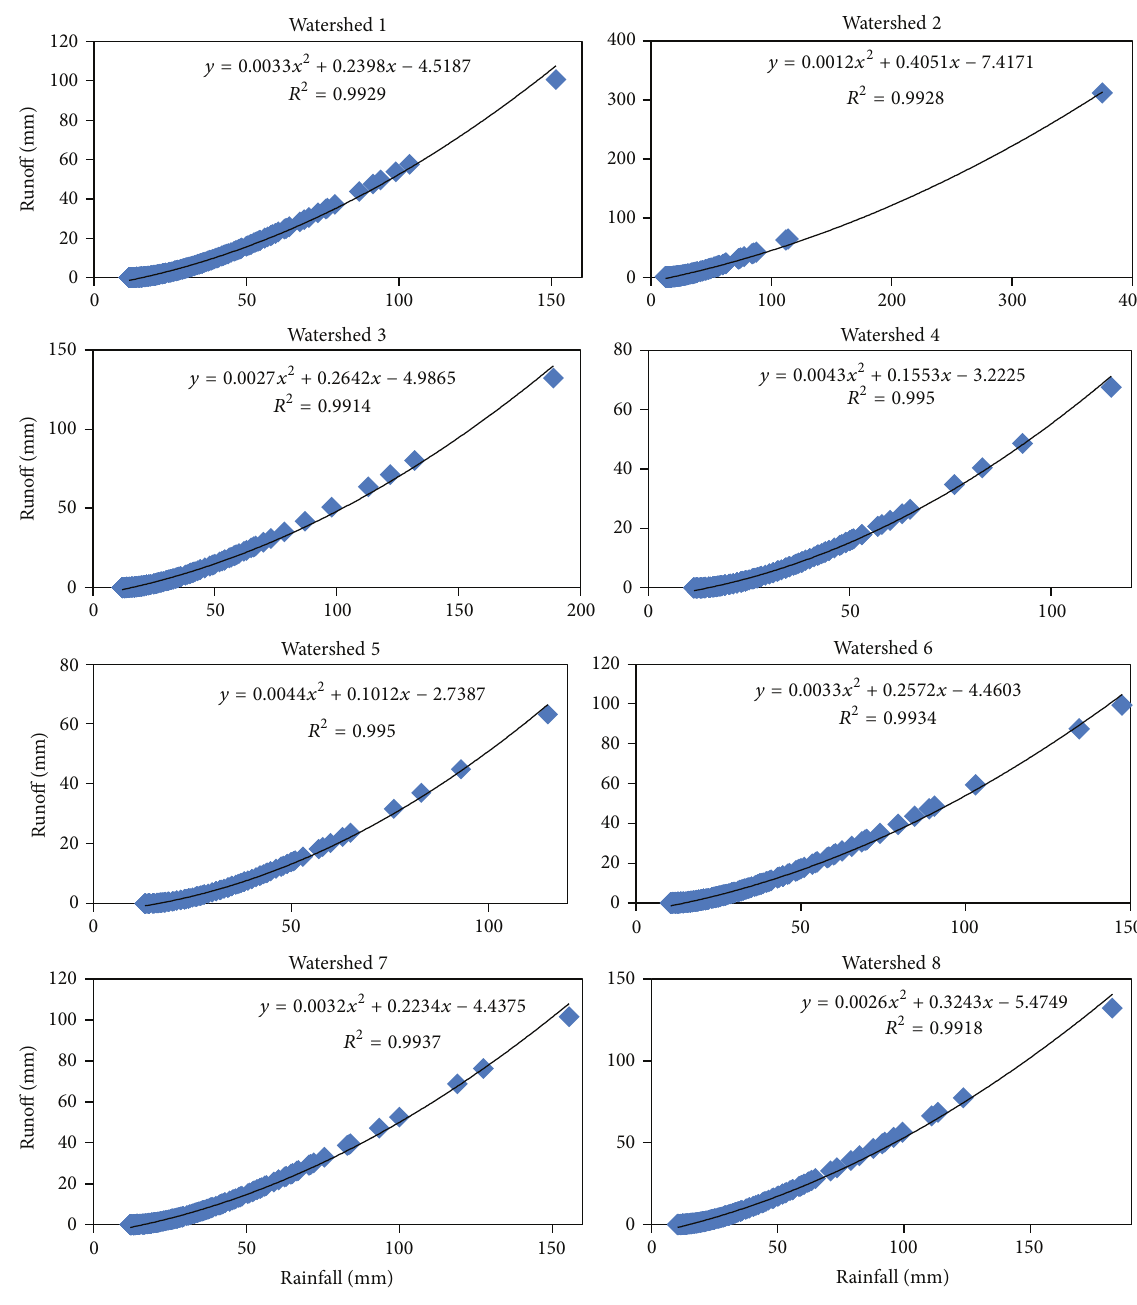
Figure 10: Estimated rainfall runoff relationship of the study